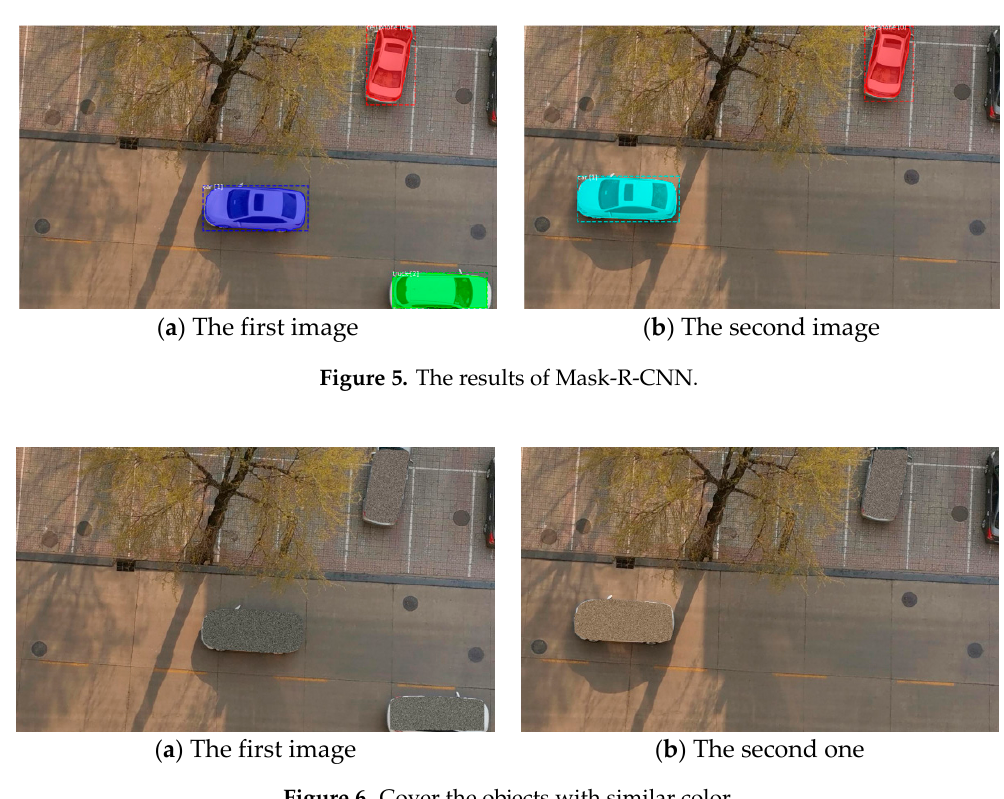
Figure 5. The results of Mask-R-CNN.